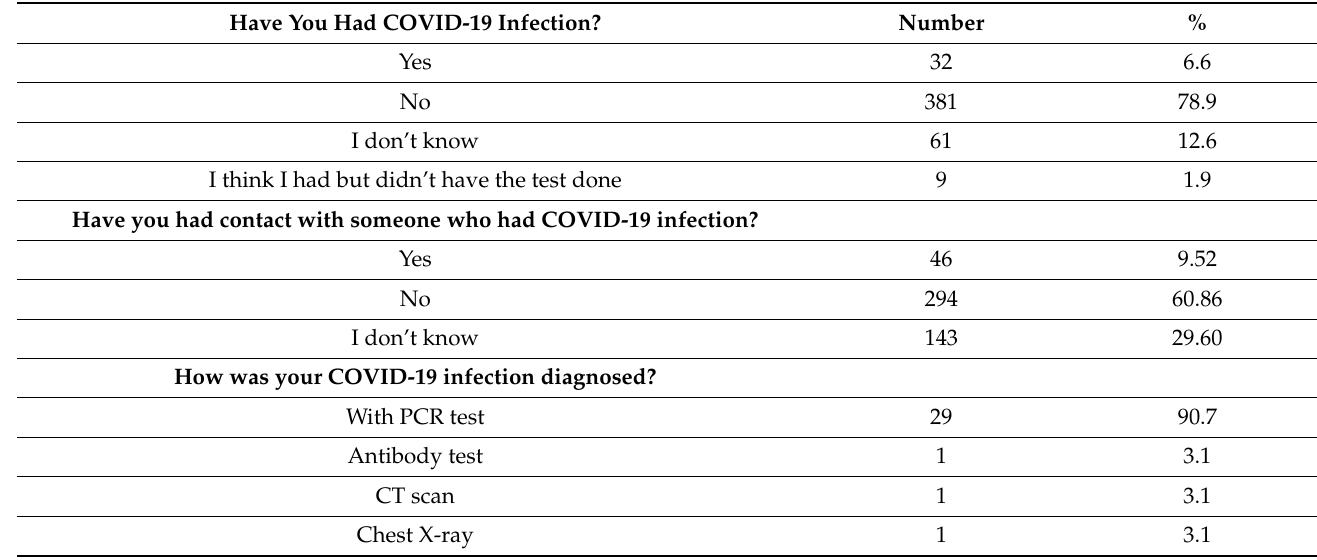
Table 2. Status of infection with COVID-19 of participants ( N = 483).